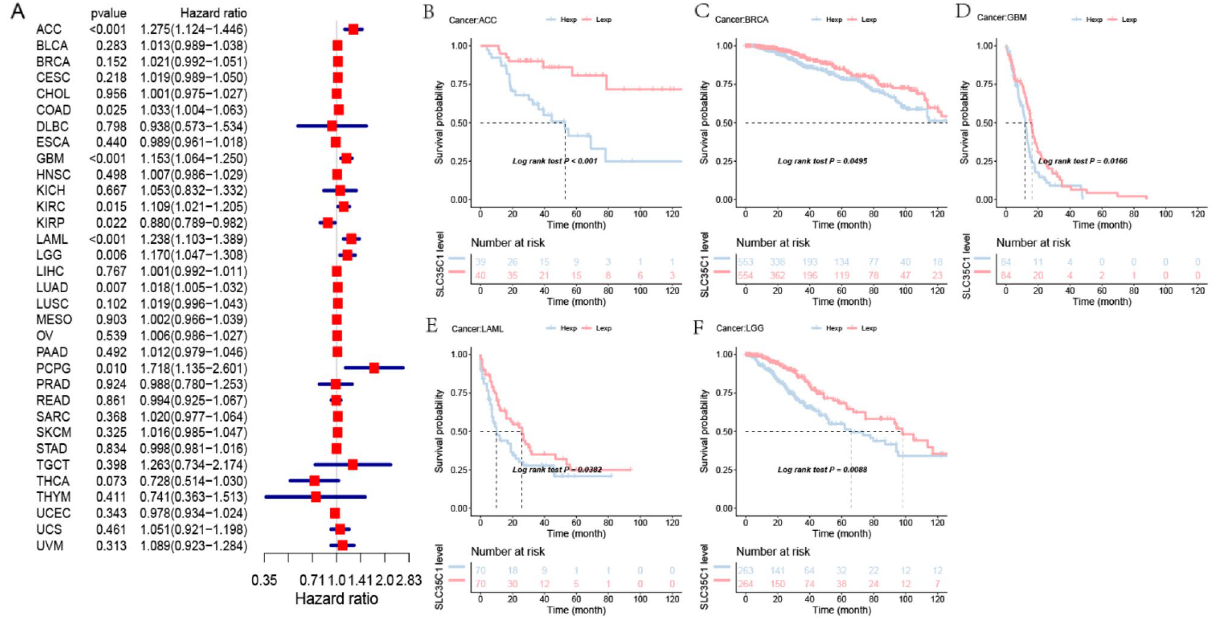
Figure 3. Association of SLC35C1 expression with patient overall survival (OS) in pan- cancer. ( A ) Forest plot of HR for the relationship between SLC35C1 expression and patient OS. ( B – F ) Kaplan–Meier analyses show the association between SLC35C1 expression and OS. Statistical significance was assessed using the log-rank test.